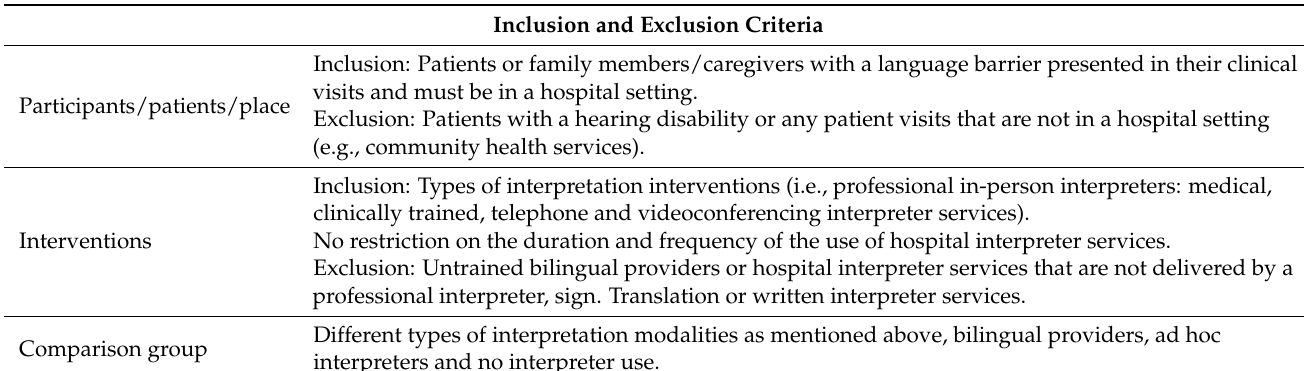
Table 1. Inclusion and exclusion criteria to assess articles. Inclusion and Exclusion